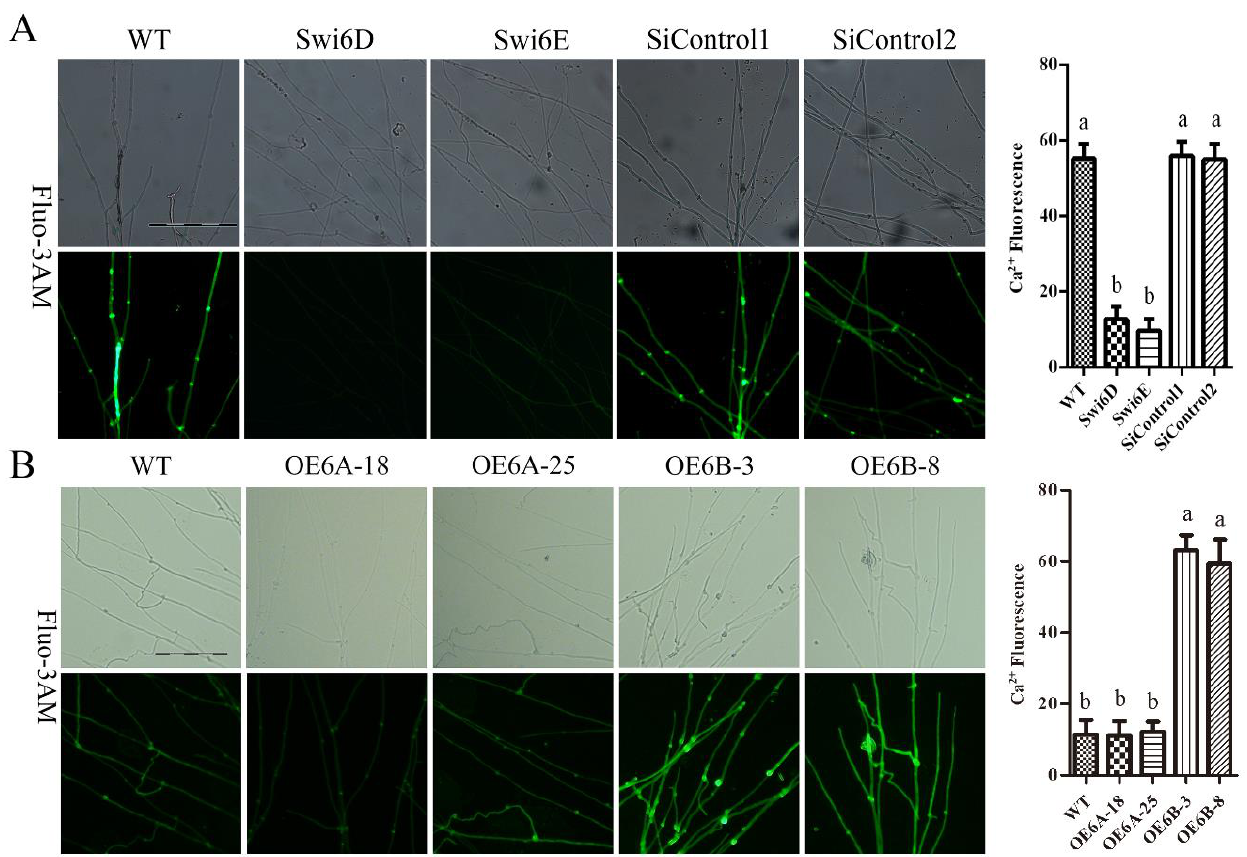
Figure 3. Cytosolic Ca 2+ content in GlSwi6-silenced and overexpression strains. The GlSwi6-silenced strains were cultured on CYM plates at 28 °C for 5~7 days. ( A ) The Fluo-3AM staining (scale bar = 0.1 mm). ( B ) Analysis of Ca 2+ fluorescence. The values are the mean ± SE ( n = 3). Different letters indicate significant differences between the strains ( p < 0.05, Tukey′s test).